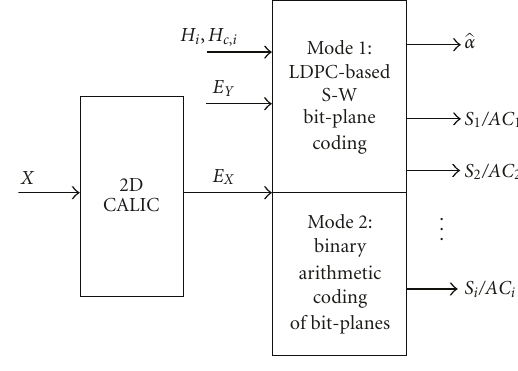
Figure 1: Block diagram of the proposed